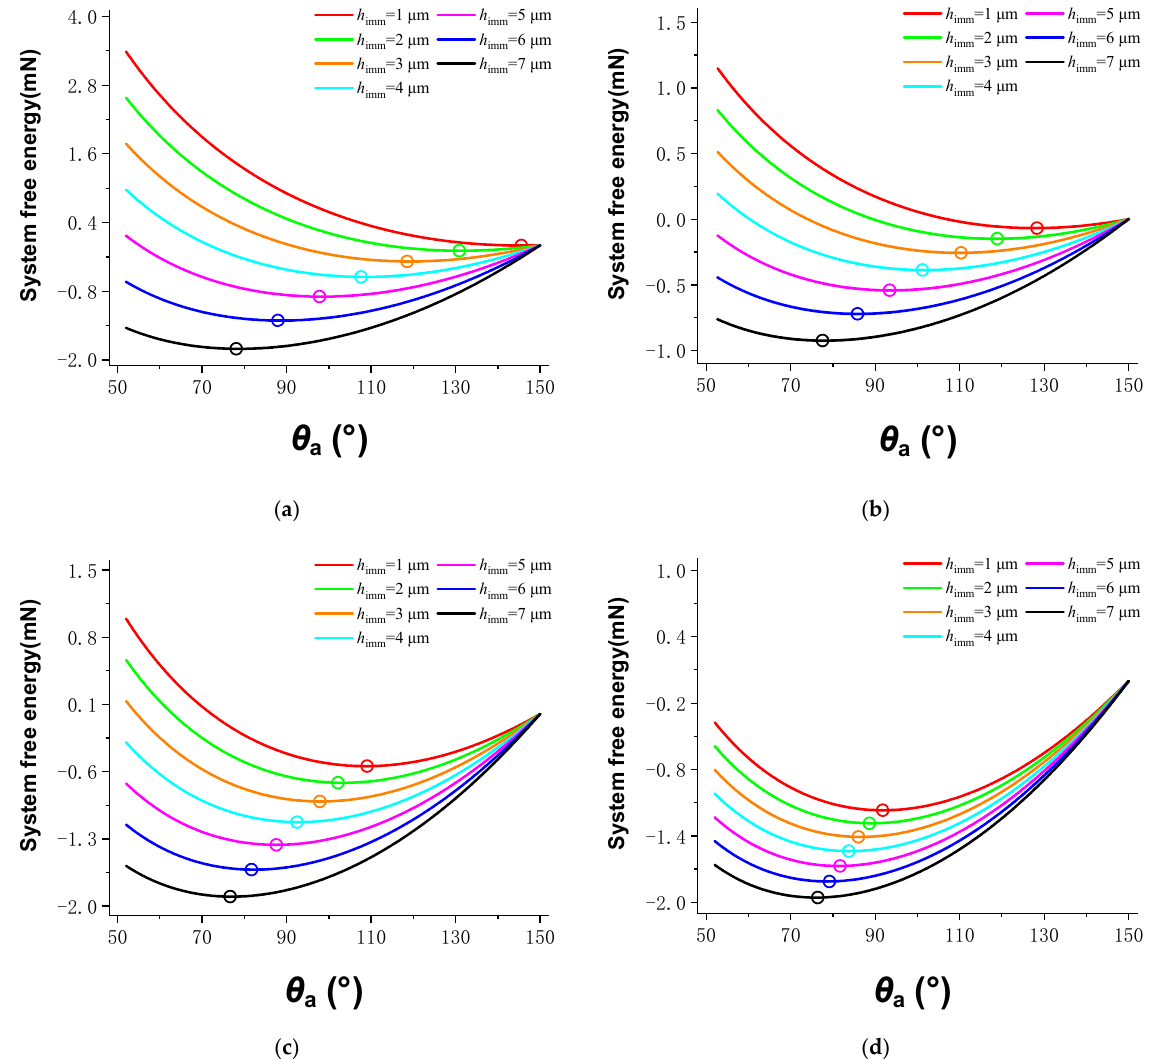
Figure 5. Apparent contact angle and system free energy under different microstructure spacings. ( a ) p = 16 μ m; ( b ) p = 20 μ m; ( c ) p = 30 μ m; ( d ) p = 60 μ m.